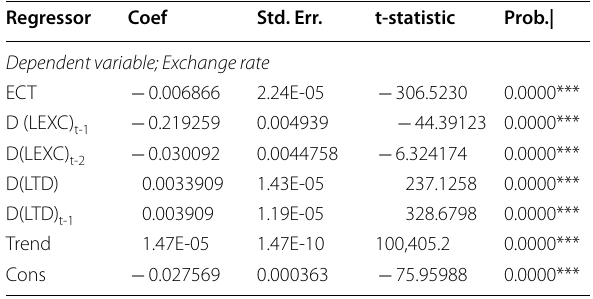
Table 4 Pooled mean group